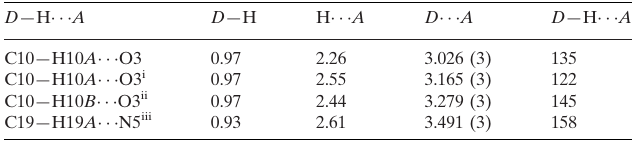
Hydrogen-bond geometry (A˚ , (cid:3)